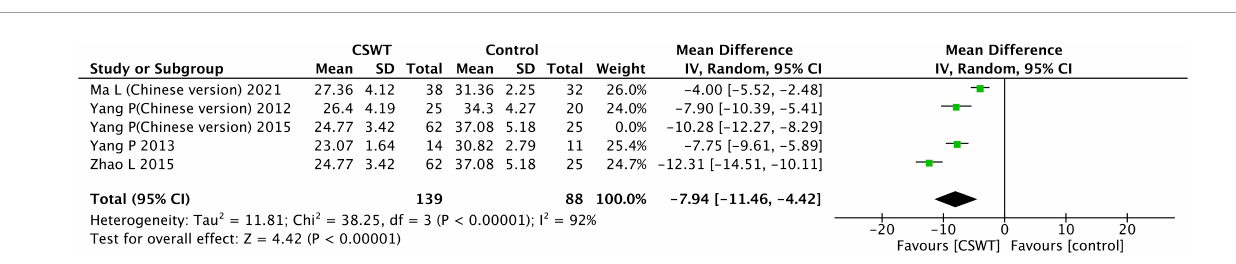
FIGURE12 Forest plot of the CSWT group vs. the control group-total score of perfusion imaging.